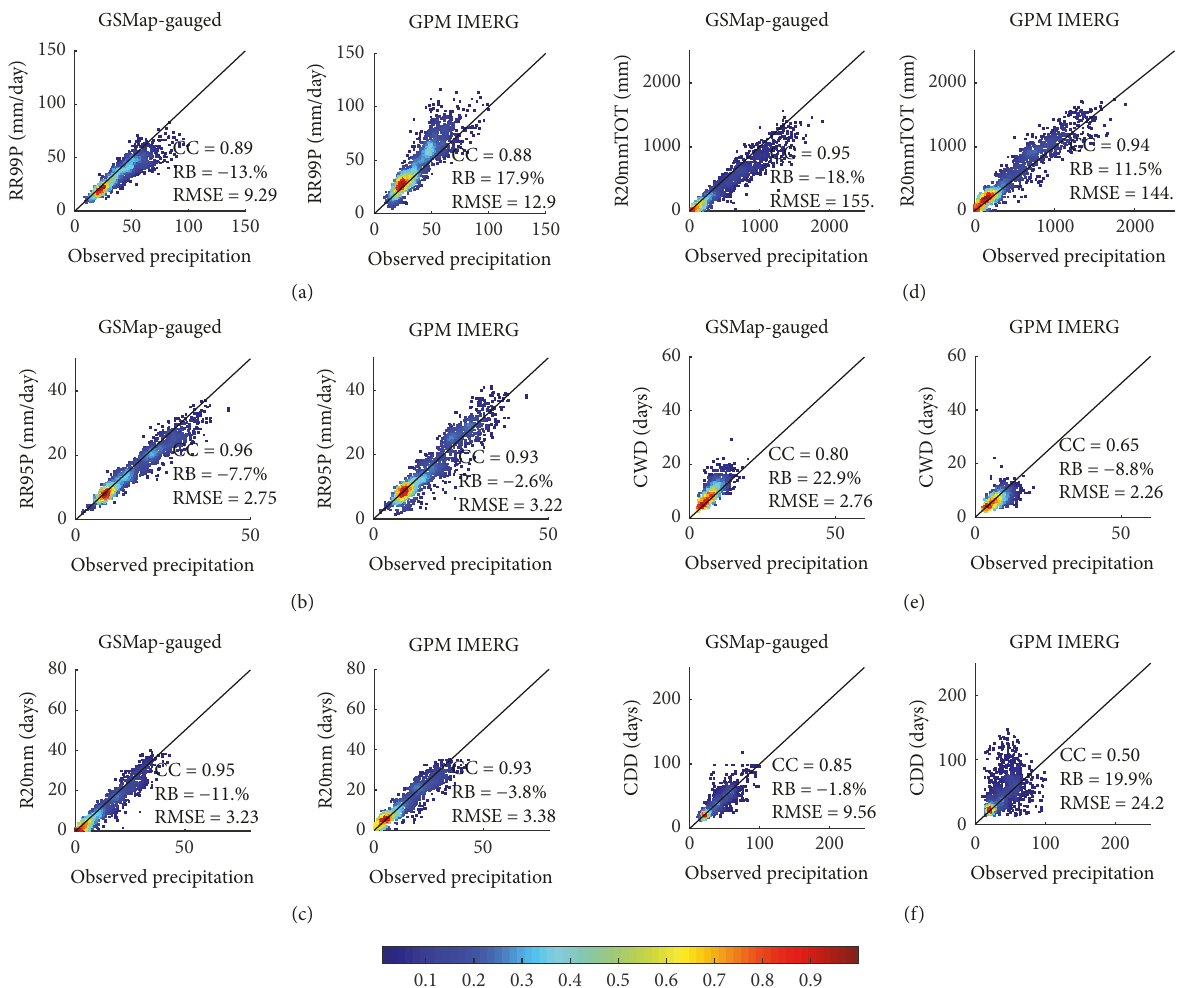
Figure 7: Scatter diagrams of extreme precipitation indices between GSPPs and observations over eastern China. The color represents the occurrence possibility and red color region shows that more percent of points are located